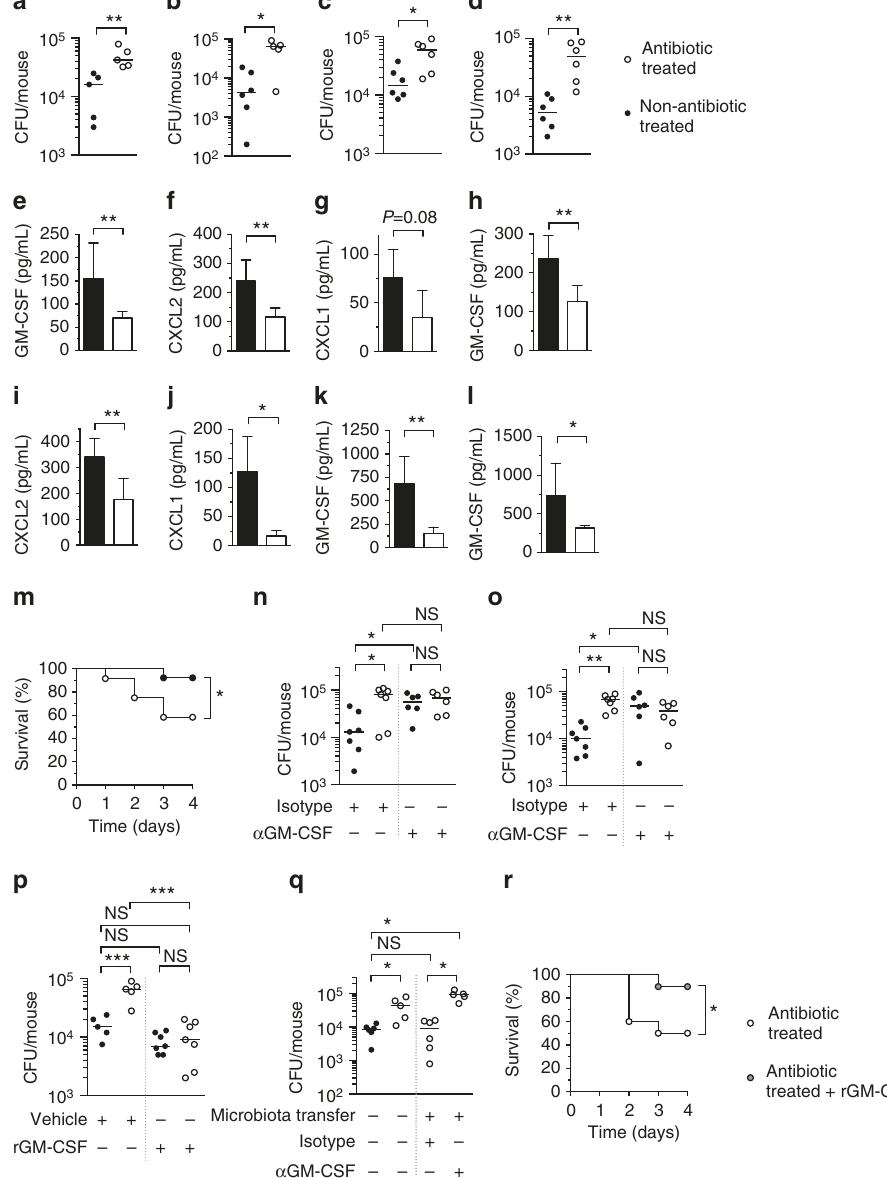
Fig. 1 The microbiota protects against Gram-negative and Gram-positive lung infection via GM-CSF signaling. a , b S . pneumoniae and c , d K . pneumoniae burden 6 h ( a , c ) and 12 h ( b , d ) post-intranasal inoculation. e – j Cytokine levels in lung tissue 12 h post-inoculation with S . pneumoniae ( e – g ) and K . pneumoniae ( h – j ). k , l Cytokine levels in lung tissue 12 h post-intranasal inoculation with K . pneumoniae LPS (1 μ g/mouse) ( k ) or lipoteichoic acid (LTA) (50 μ g/mouse) ( l ). For ( e – l ) data are from n = 4 – 5 mice/group and error bars are s.d. Statistical comparisons were by Mann – Whitney ( a – f and h – l ) and Student ’ s t -test ( g ), * P < 0.05, ** P < 0.01. m Survival after intranasal challenge with S . pneumoniae ( n = 12 – 13 mice/group), groups were compared using